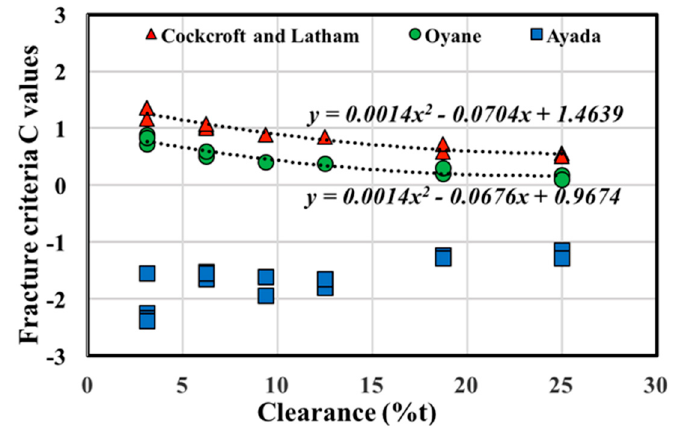
Figure 8. Relationships between the punch-die clearance and the values of fracture criteria obtained by comparing the cutting surface by FEA with the shear limit point ( l/t ) obtained from the punching experiment for different clearances and different punch diameters.